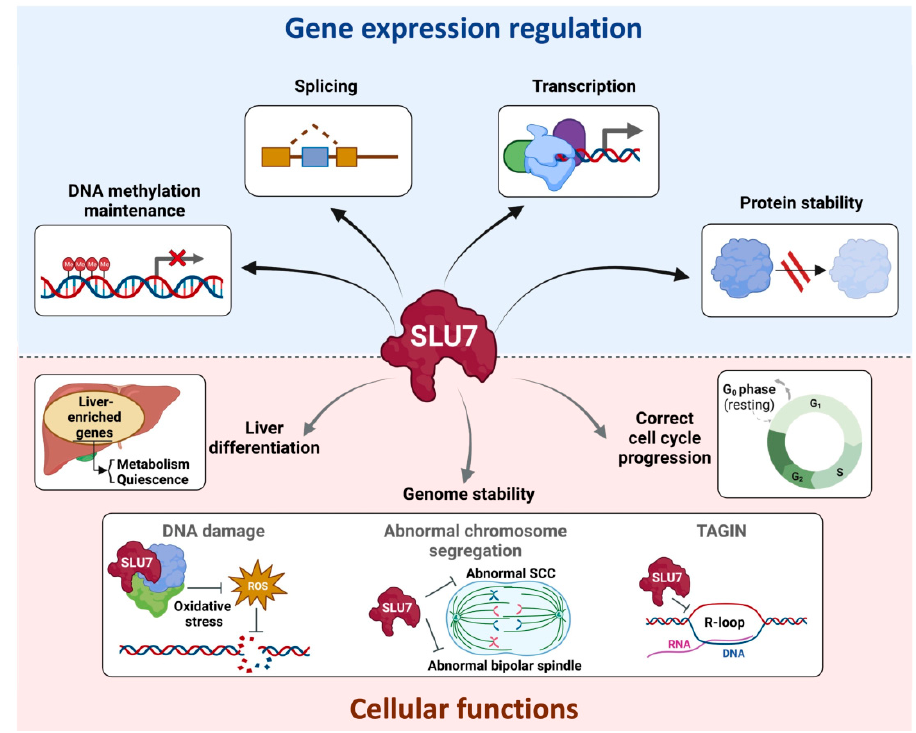
Figure 6. Schematic representation compiling the involvement of SLU7 in the regulation of gene expression at different levels and in cellular functions. See text for details. Abbreviations: ROS, reactive oxygen species; SCC, sister chromatid cohesion; TAGIN, Transcription-associated genome instability.